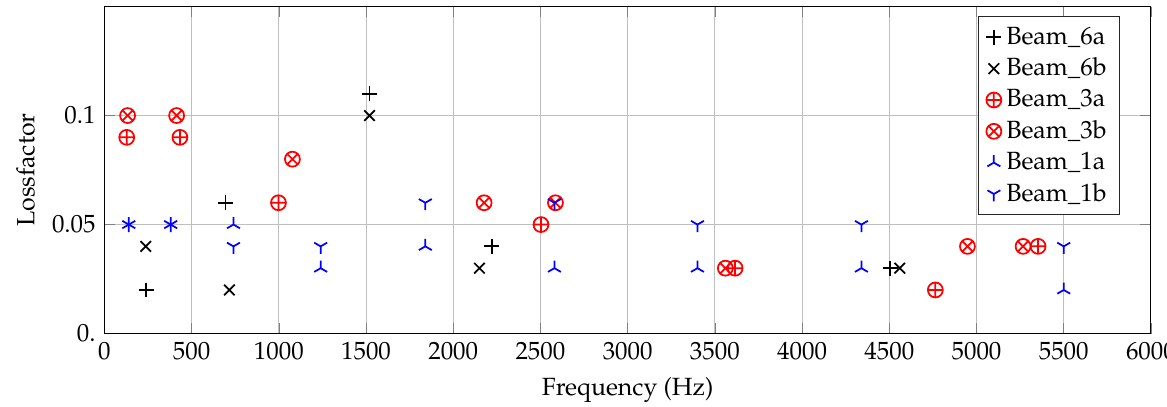
Figure 17. Identified loss factors η for all six specimens in dependency on frequency f